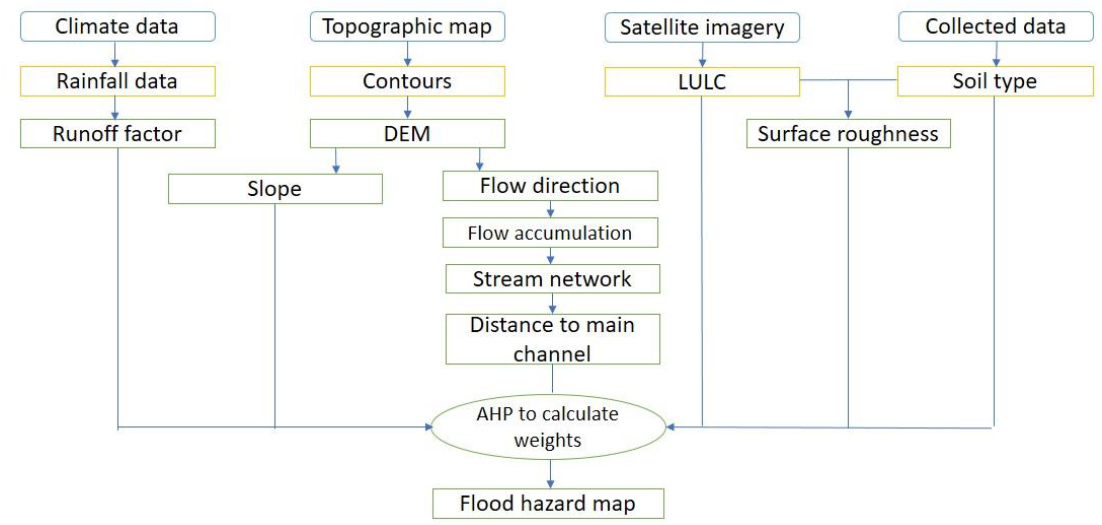
Fig. 2. Flow chart of the proposed methodology for flood hazard